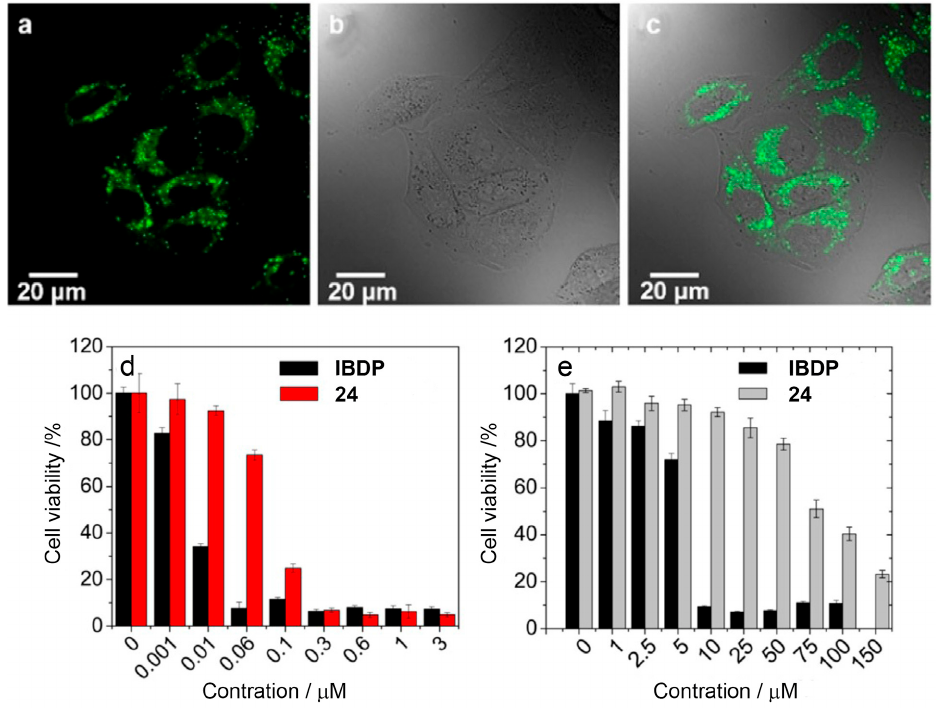
Figure 7. Confocal laser scanning microscopy images of HeLa cells after incubation with 24 ( c = 10 μ m). ( a ) Green channel (500–600 nm) fluorescence image, λ ex = 488 nm. ( b ) Bright field image. ( c ) Merged image. Scale bar: 20 μ m. Comparison of the cell viability of HeLa cells pre-treated with increasing doses of 24 and 2,6-diiodoBodipy (IBDP), ( d ) with light irradiation (500 nm, 9.6 J·cm − 2 ), ( e ) without light irradiation. 20 °C. Reproduced with permission from reference [18], copyright 2019, Wiley-VCH Verlag GmbH & Co. KGaA, Weinheim.